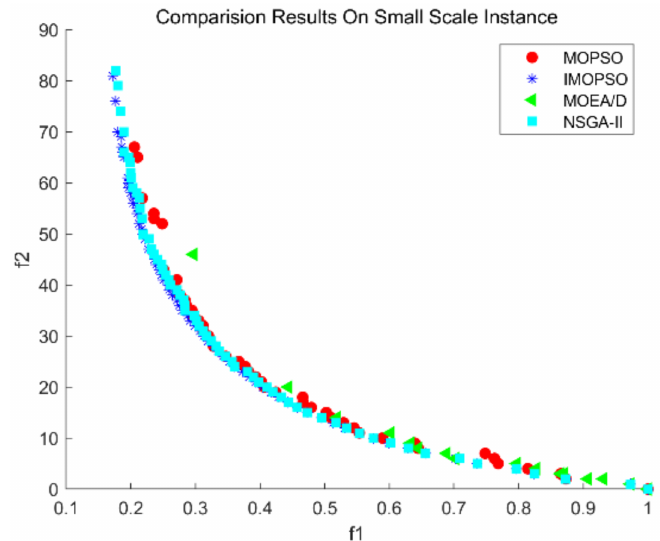
Figure 14. Comparison of four algorithms on small-scaled instance.